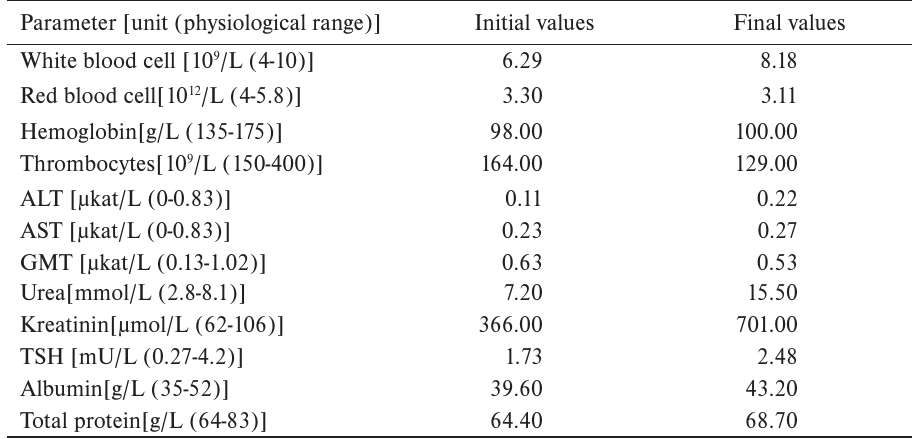
Table 1. Basic laboratory parameters before and after axitinib therapy. Parameter [unit (physiological